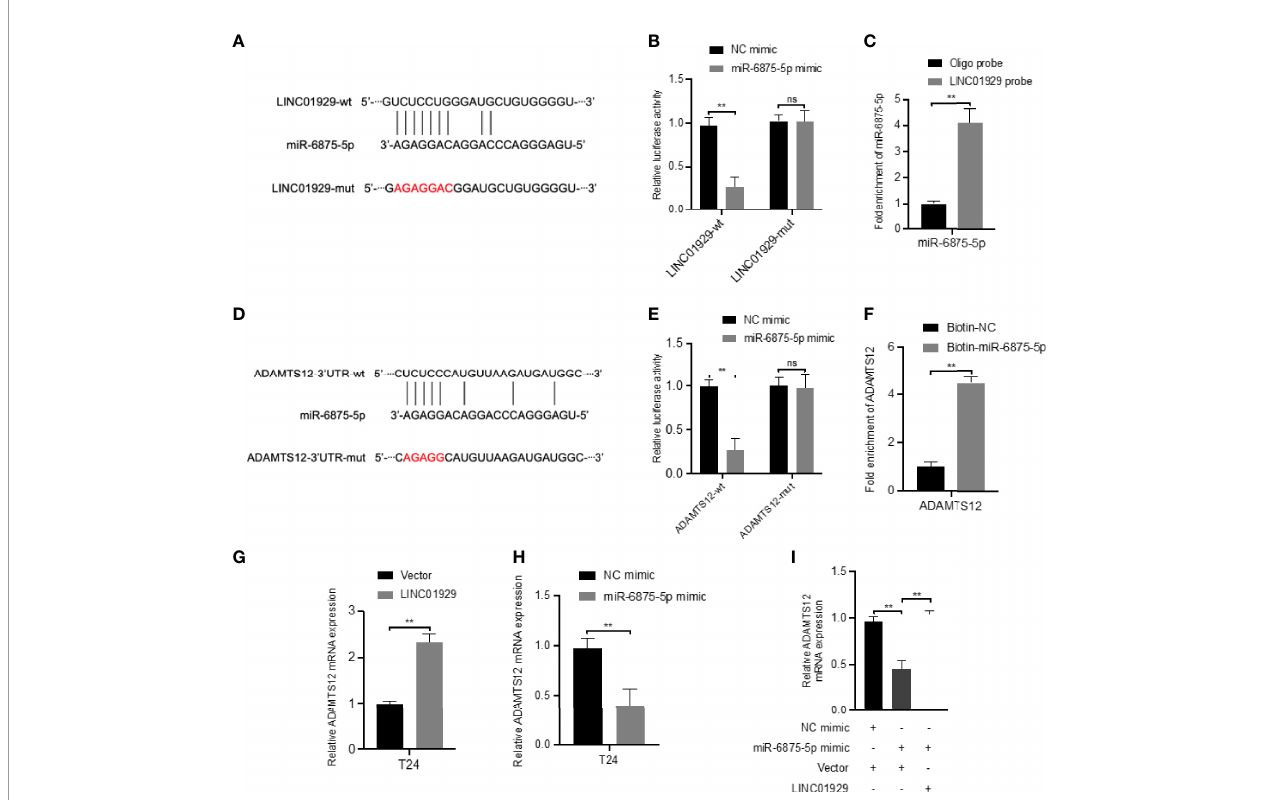
FIGURE 10 | LINC01929 antagonizes miR-6875-5p mediated repression of ADAMTS12 expression. (A) Schematic illustration showed the alignment of miR-6875-5p with LINC01929 and the red portion indicated the mutagenesis nucleotides. (B) Dual luciferase reporter assays showed the luciferase activity of wild type or mutant LINC01929 following co-transfection with miR-6875-5p mimic or control mimic. Relative fi re fl y luciferase expression was normalized to that of Renilla luciferase. (C) RNA pulldown assays revealed that miR-6875-5p directly interact with LINC01929 in T24. (D) Schematic illustration showed the alignment of miR-6875-5p with ADAMTS12 and the red portion indicated the mutagenesis nucleotides. (E) Dual luciferase reporter assays showed the luciferase activity of wild type or mutant ADAMTS12 following co-transfection with miR-6875-5p mimic or control mimic. (F) RNA pulldown assays showed that ADAMTS12 was captured by biotinylated miR-6875-5p. (G, H) The effect of LIN01929 and miR-6875-5p overexpression on ADAMTS12 mRNA expression in T24 cells was assessed by qRT-PCR. (I) qRT-PCR analyzed the effect of overexpressed LIN01929 on miR-4875-5p overexpression-induced ADAMTS12 expression in T24 cells. **P < 0.01. The extended form of “ ns ” is “ no signi fi cance ” , which means that there is no statistical difference between the two